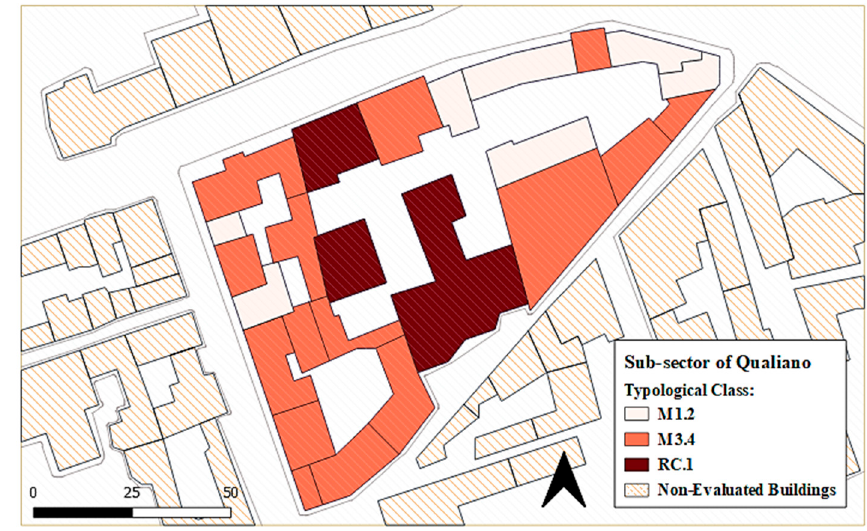
Figure 4. The main typological classes of the examined sub-sector.